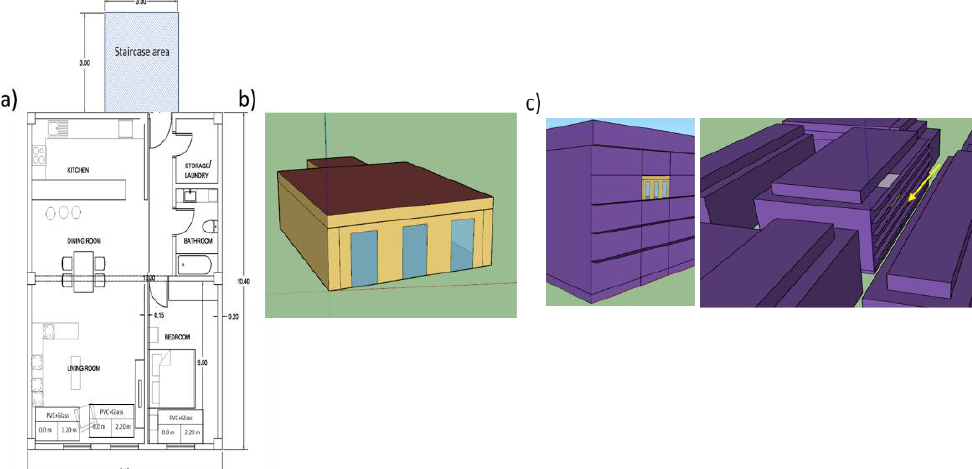
Figure 7. ( a ) Plan of the investigated building unit, ( b ) the 3D model of the zone in the EnergyPlus model along with ( c ) its surrounding obstacles.